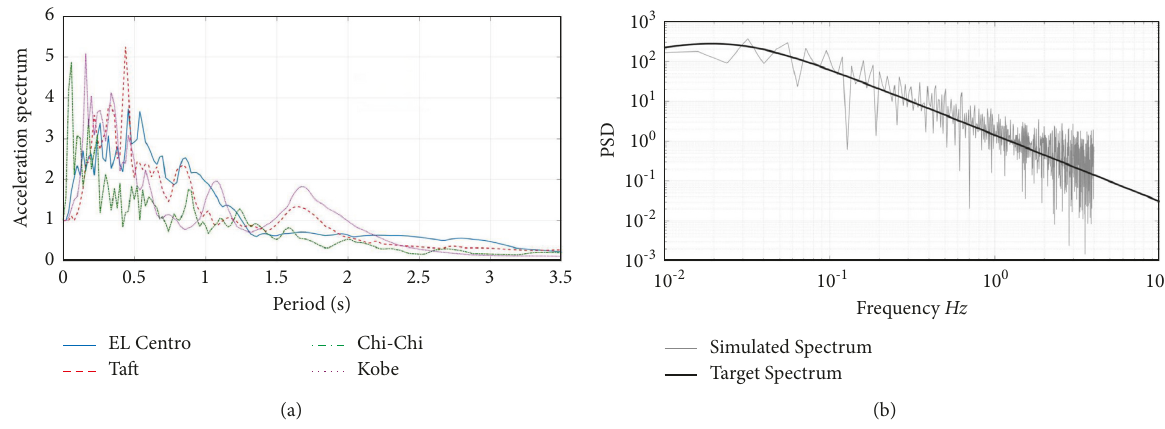
� 1, μ � 0.1, ζ � 0.11, ζ � 0.02). d d d